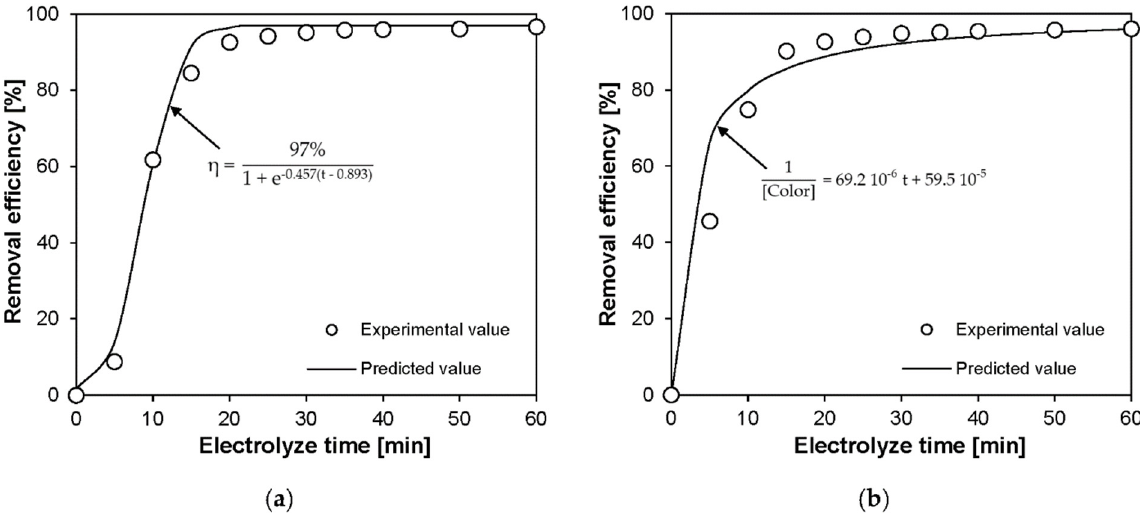
Figure 6. Removal efficiency from experimental and predicted values under 4.5 mA/cm 2 of ( a ) turbidity and ( b ) color.